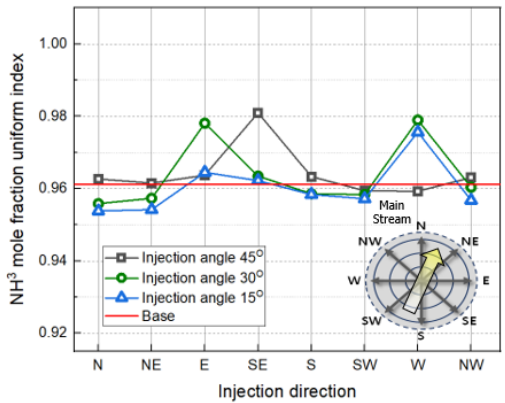
Figure 13. Ammonia uniformity index (UI) according to the various injection angle and direction candidates at the inlet of the SCR. candidates at the inlet of the Table 4. Ammonia uniformity index (UI) data according to the various injection angle and direc- tion candidates at the inlet of the SCR.